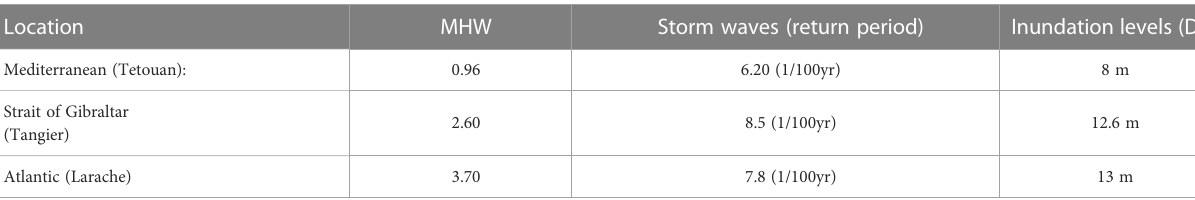
TABLE 1 Description of parameters used in Hoozemans equation to calculate maximum inundation levels for the main facades of the TTA region (Laboratoire Central d ’ Hydraulique de France (1974); Snoussi et al., 2008; El Mrini, 2011; Taouati et al., 2011; Khouakhi et al., 2013). Location MHW Storm waves (return period) Inundation levels (Dft) Mediterranean (Tetouan): 0.96 Strait of Gibraltar